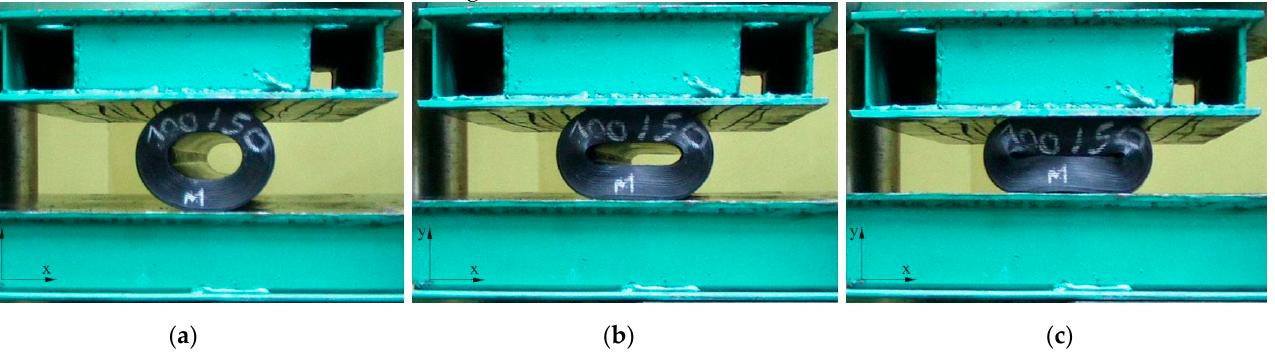
Figure 6. Stages of deformation of the experimental model of a cylindrical fender 100 mm × 50 mm × 500 mm until 50% deflection is achieved. ( a ) Stage 1, y = − 12.5 mm; ( b ) Stage 2, y = − 25.0 mm; ( c ) Stage 3, y = − 50.0 mm.